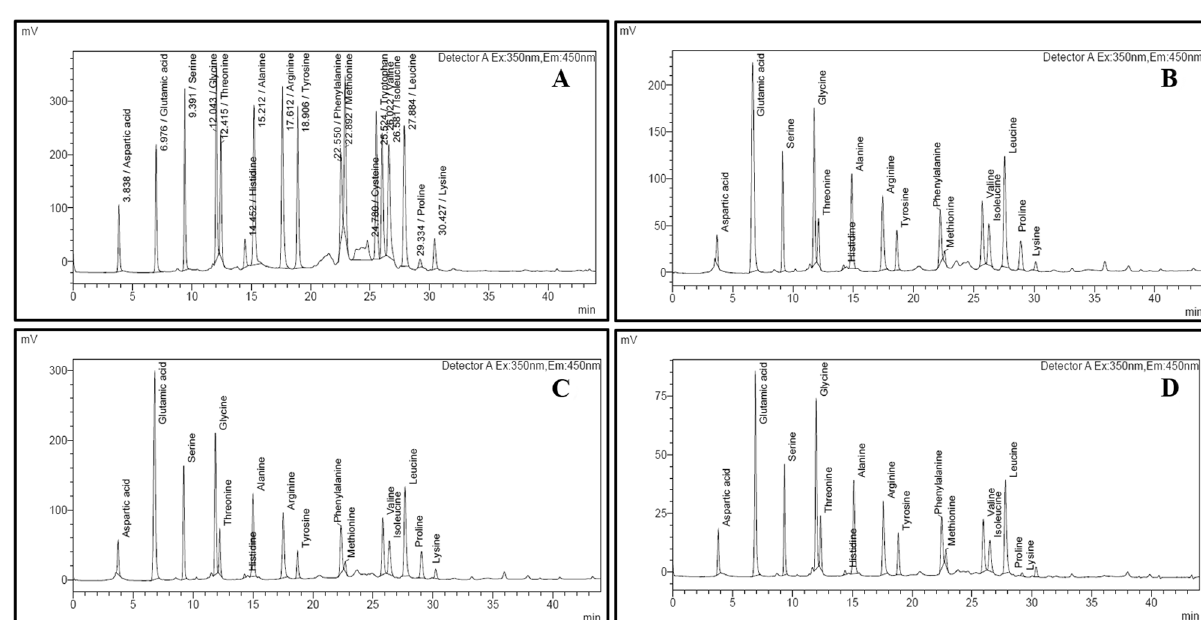
Figure 2. HPLC Chromatograms displaying ( A ) 500 mmol standard mixture of 18 Amino acids; ( B ) Gliadin, HPW-42 ( C ) Secalin, MCTLG-5, ( D ) Hordein,